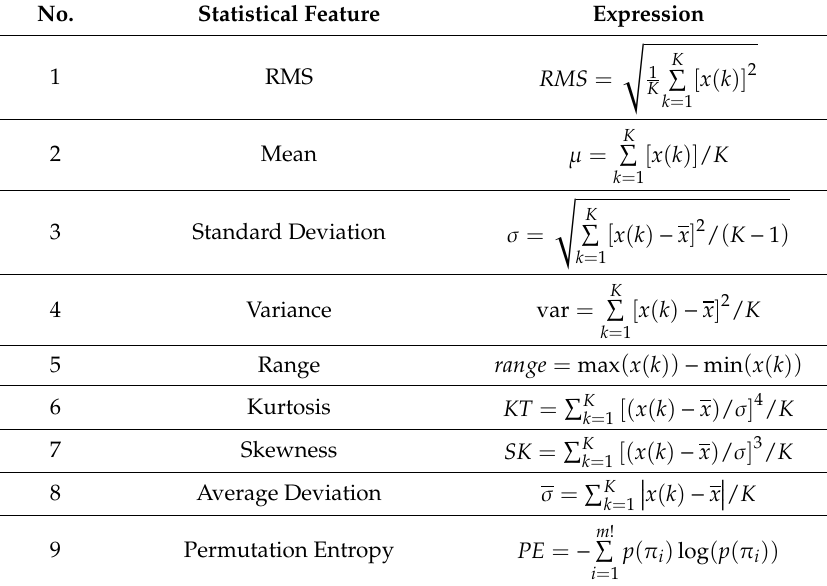
Table 2. Statistical parameters for feature